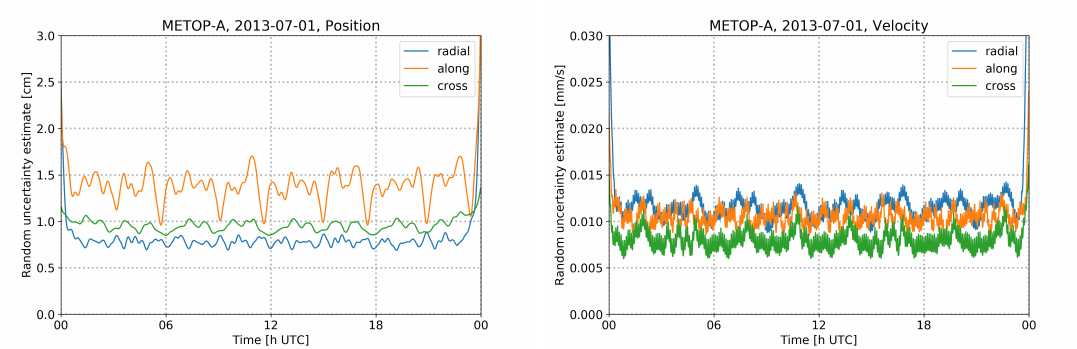
Figure 2. Propagated random uncertainty estimates (based on propagating standard errors) from Bernese for Metop-A on an example day (1 July, 2013), for position ( left ) and velocity ( right ), for the radial, along-track, and cross-track components. Coverage factor of 2